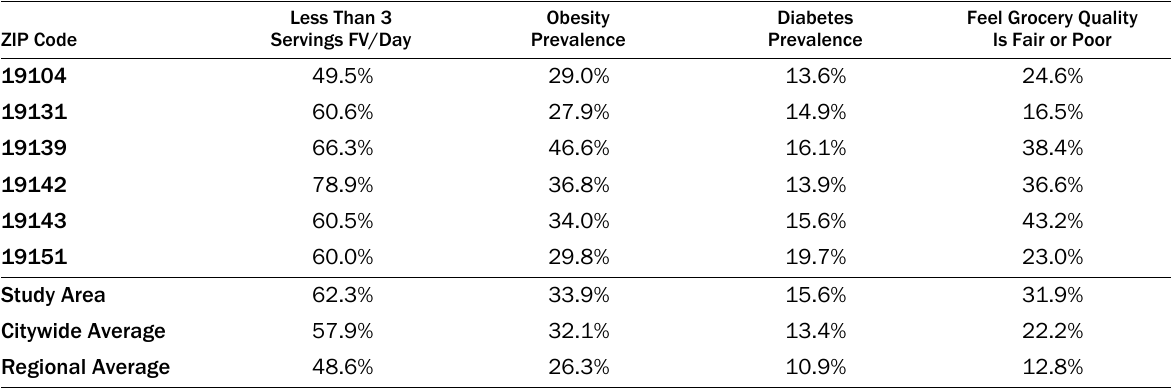
Table 1. Health Indicators for Study Area Versus Citywide and Regional Averages ZIP